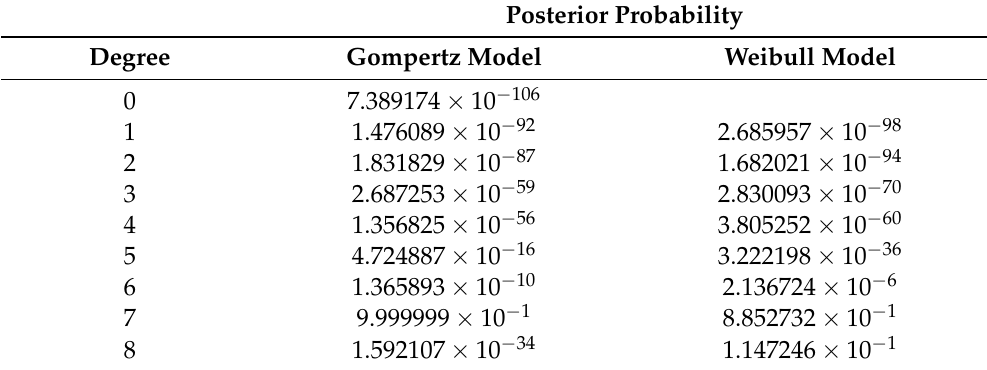
Table 7. Study of deceased: Posterior probabilities of the polynomial regression model of degree less than or equal to